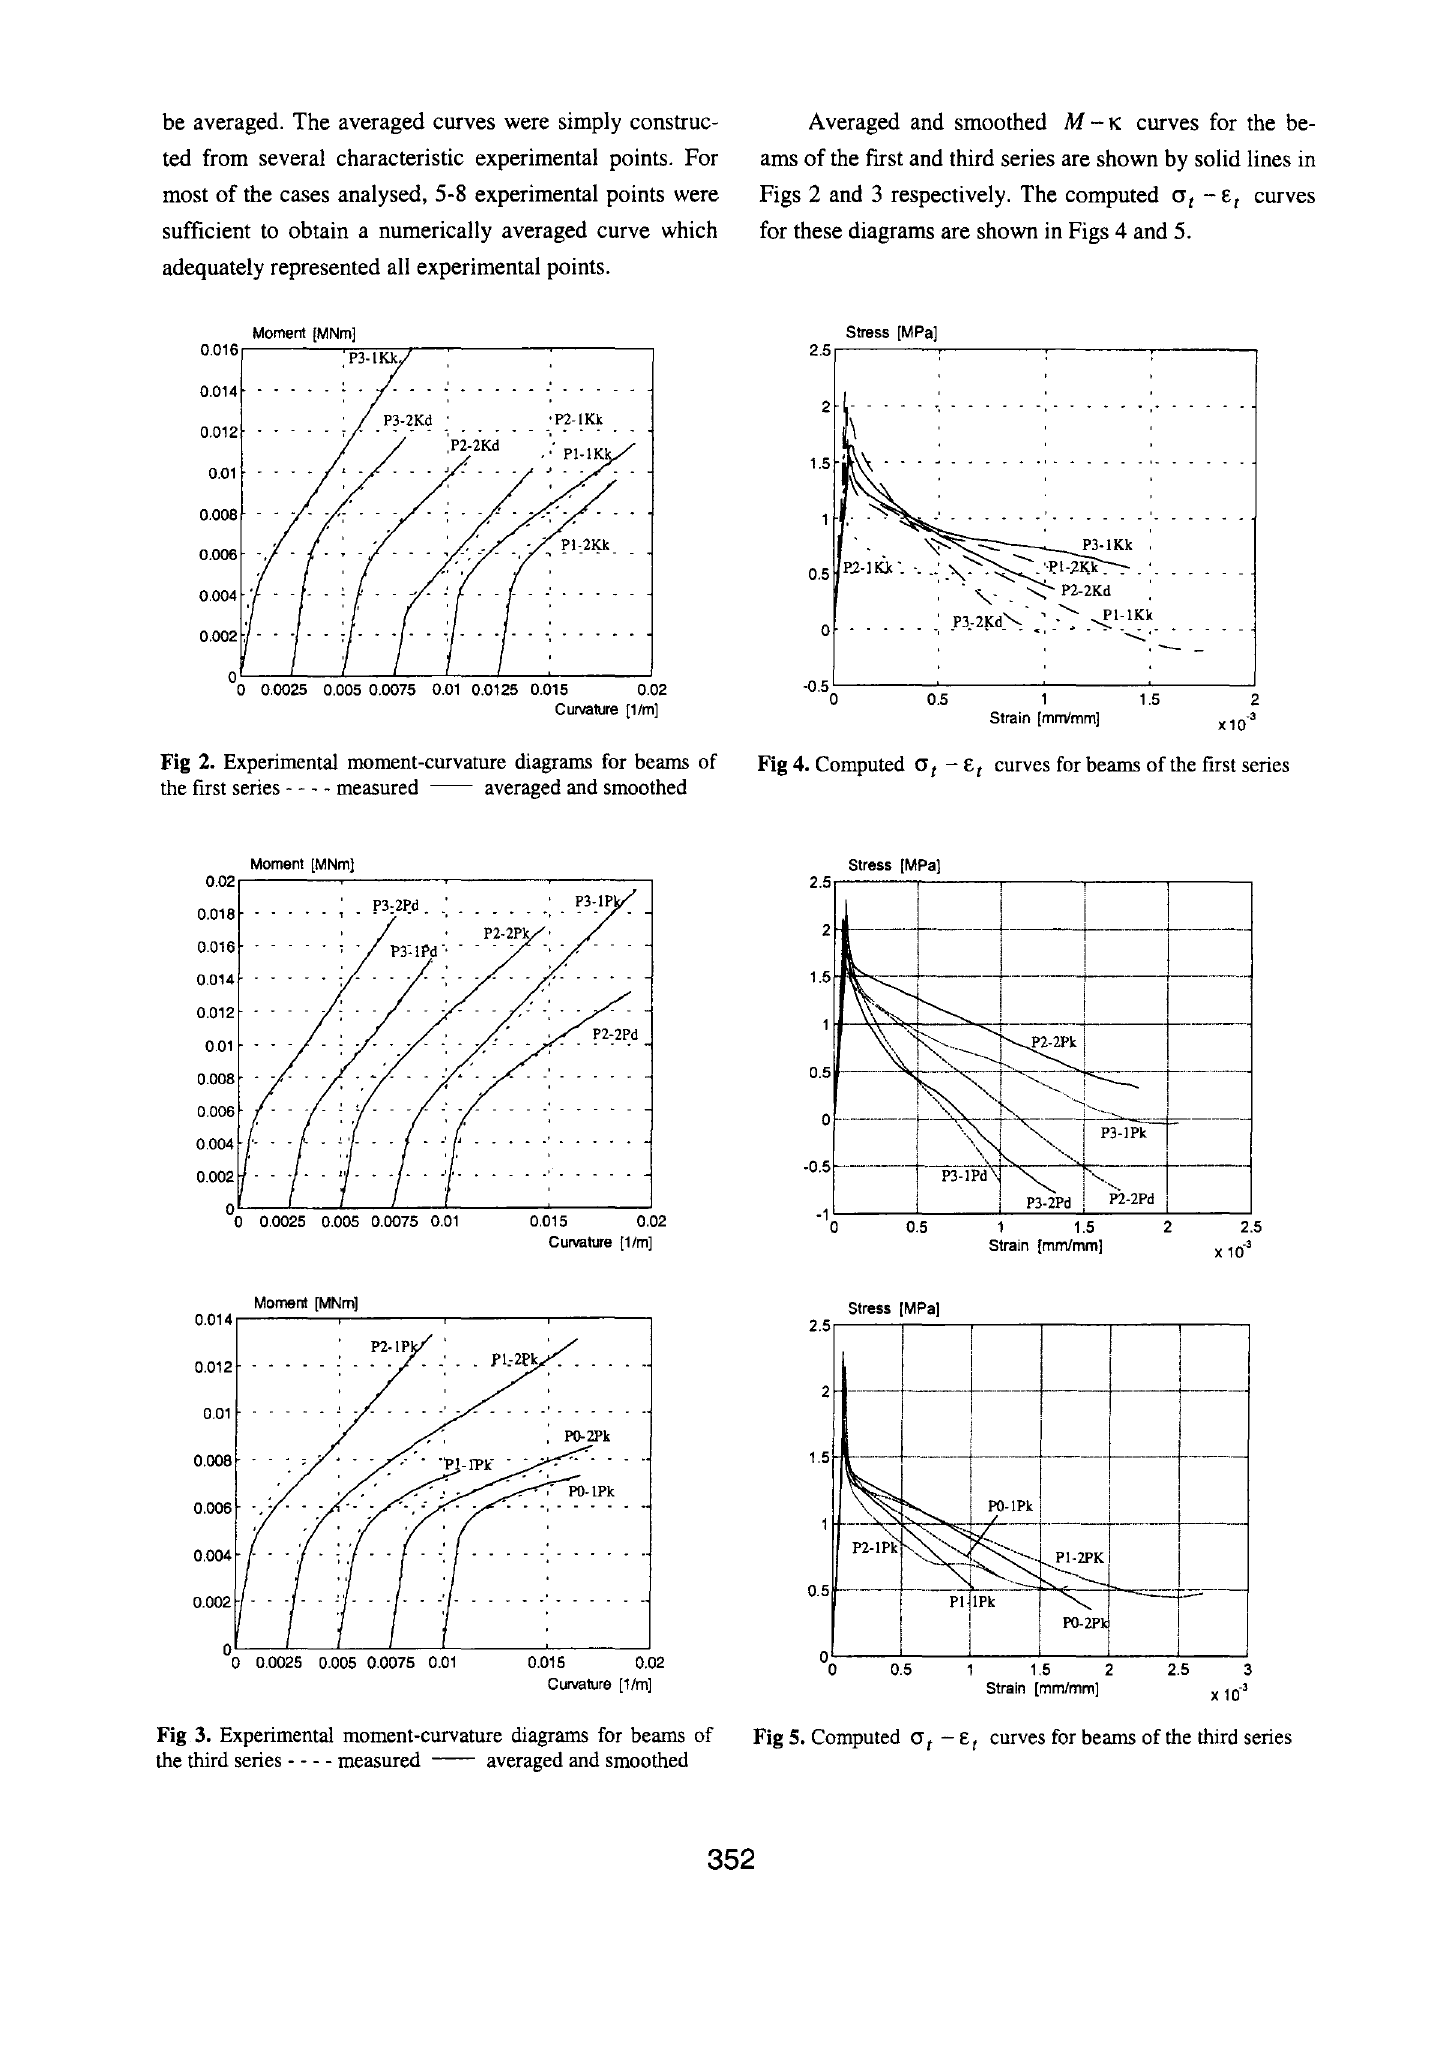
curves for beams of the third series Fig 5. Computed CJ 1 - f. 1